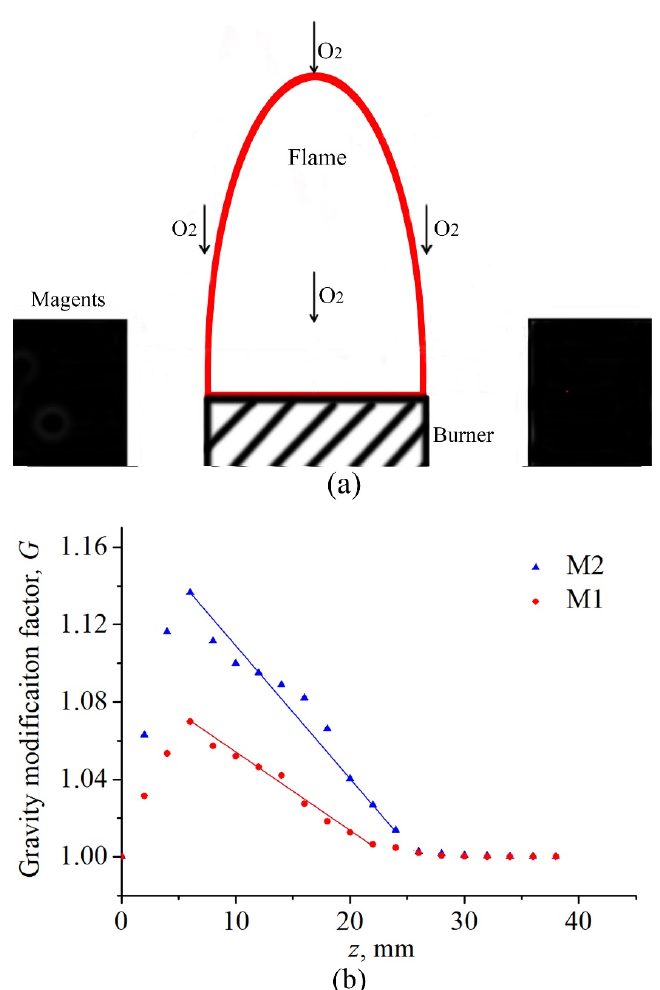
Figure 8. ( a ) Illustration of magnetic forces on oxygen inside and outside the flame: The vertical direction indicated by the black arrow is the force direction of oxygen; ( b ) Reinforced gravity effect in terms of gravity modification factor G versus elevation.